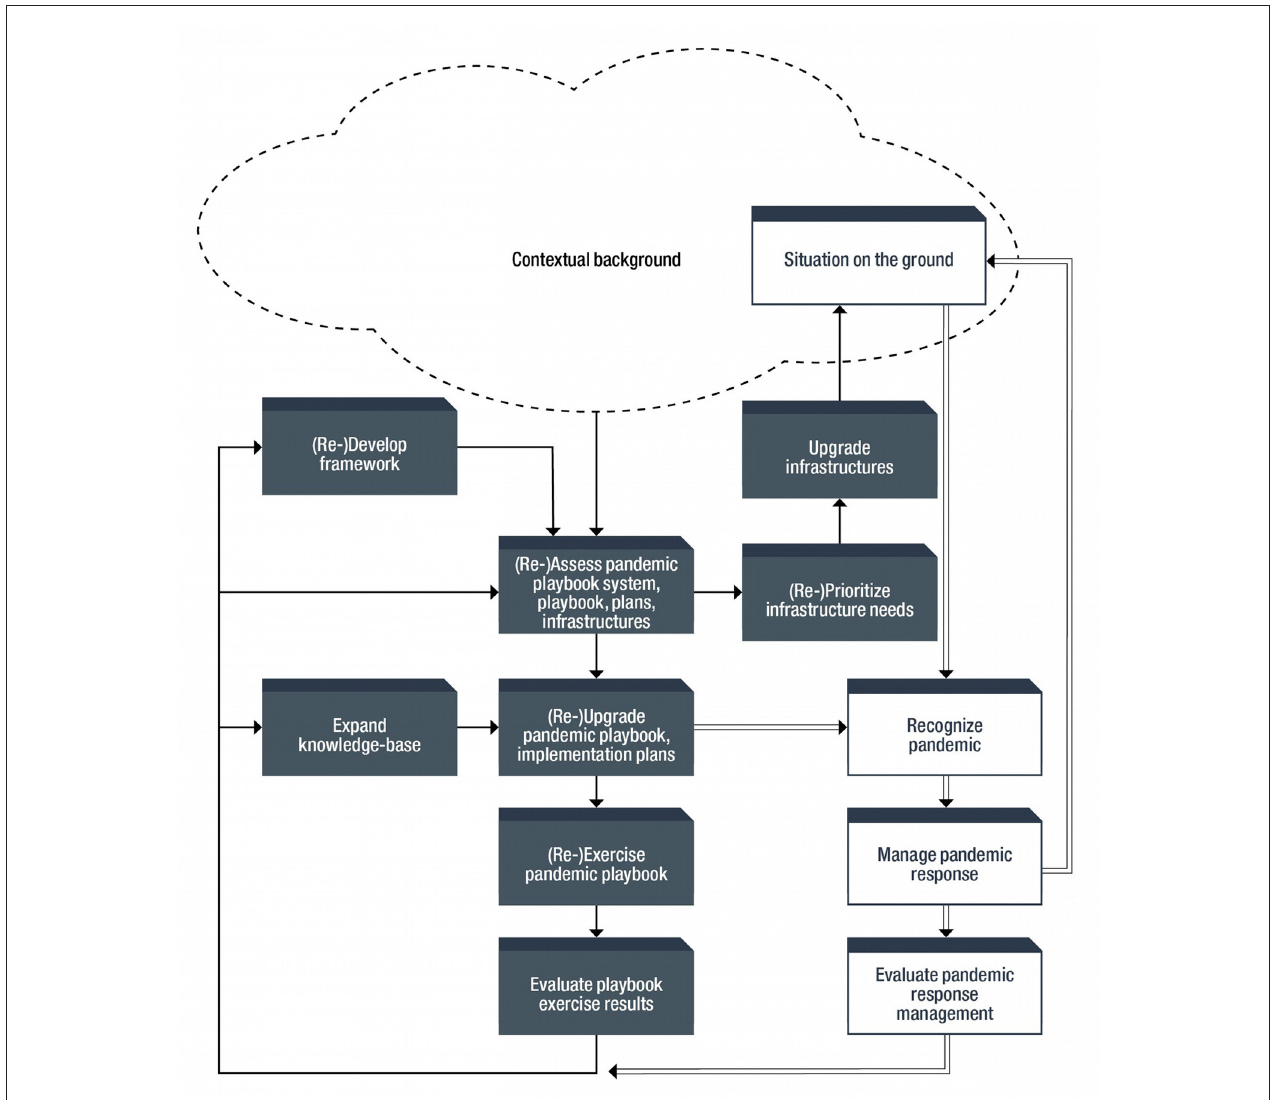
FIGURE 2 | Pandemic response management